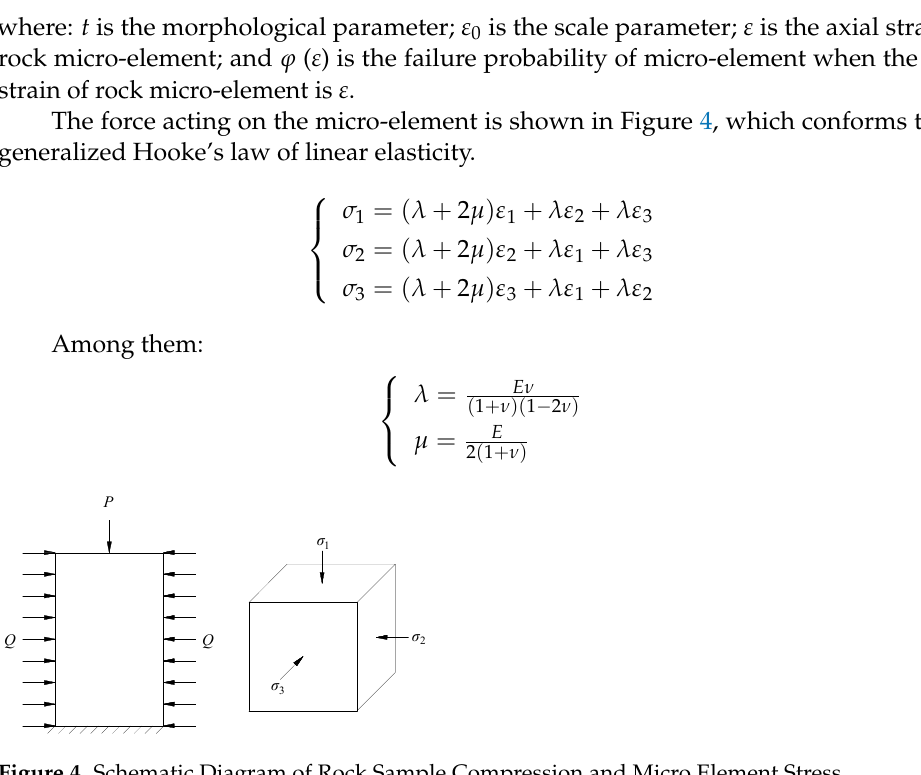
Figure 4. Schematic Diagram of Rock Sample Compression and Micro Element Stress.